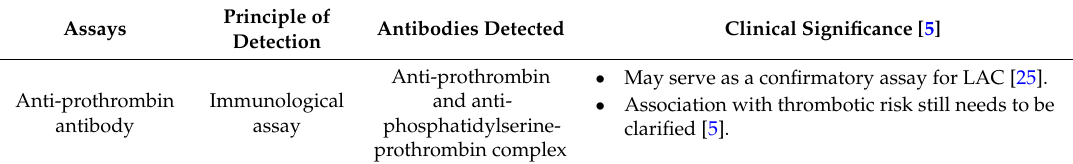
Table 1. Cont. Principle of Antibodies Detected Clinical Significance [5] Assays Detection Anti-prothrombin